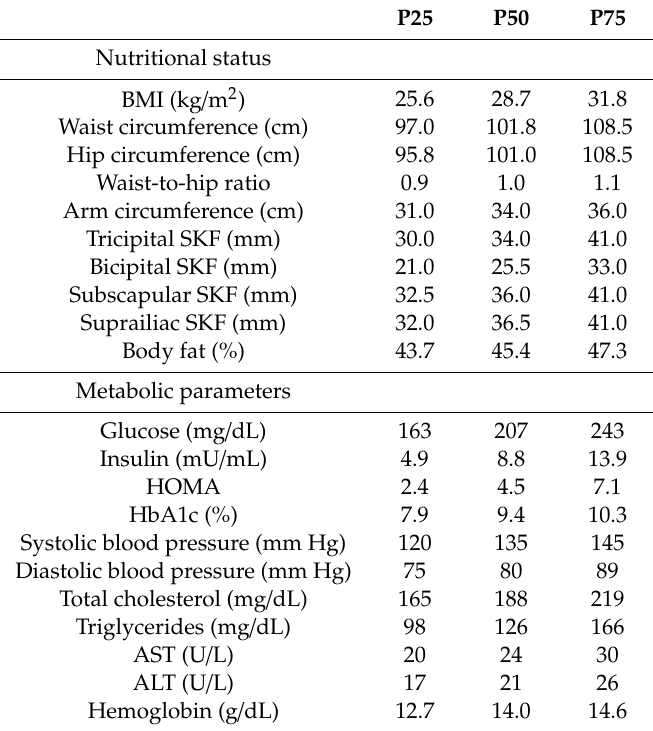
Table 2. Nutritional and metabolic characteristics of the recruited women.